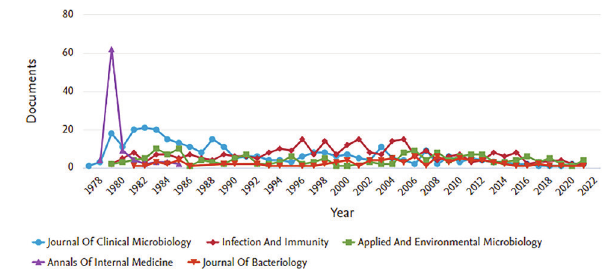
Figure 2 - Published numbers of top 5 journals by